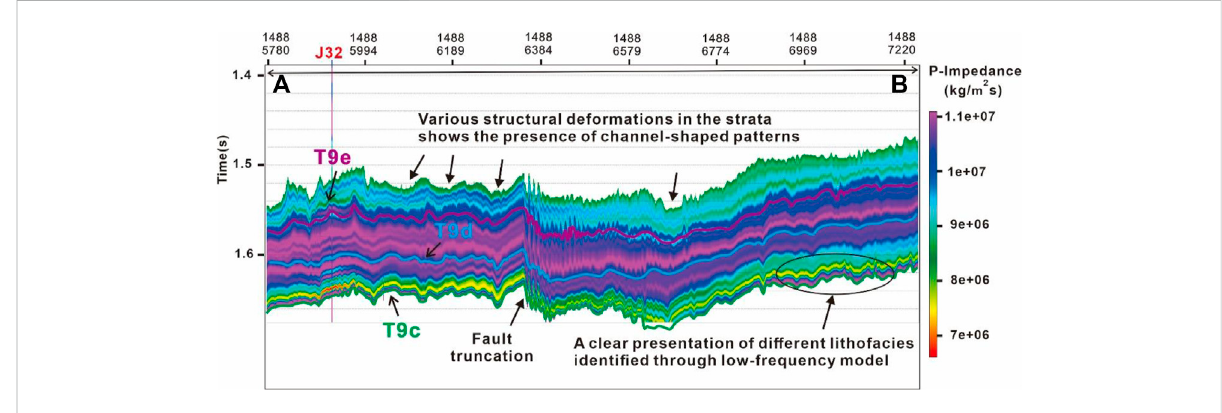
FIGURE 6 Low-frequency model of the ZOI that shows the presence of fault truncations and channel-shaped patterns associated with structural variations. A highlighted zone evidently highlights the presence of various